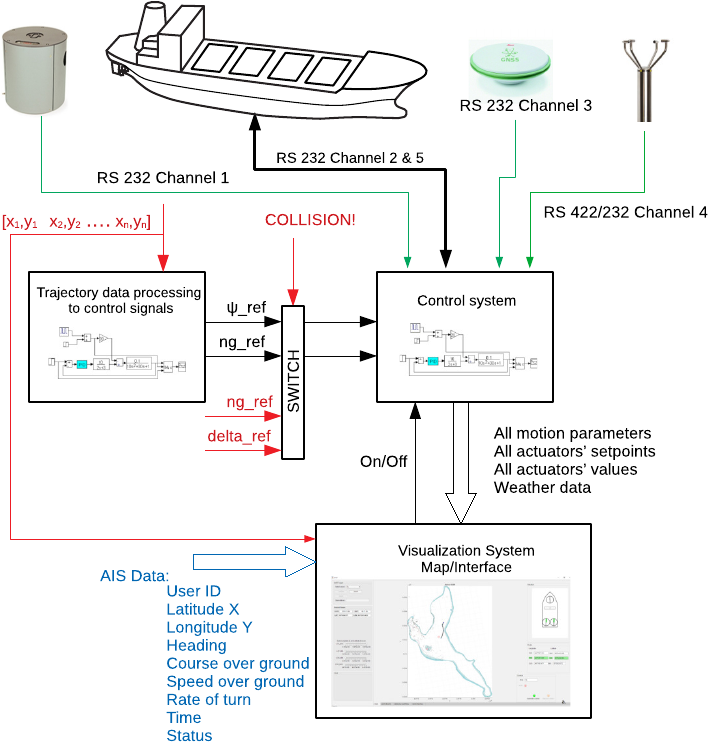
Figure 7. Autonomous training ship motion control system—block diagram of main